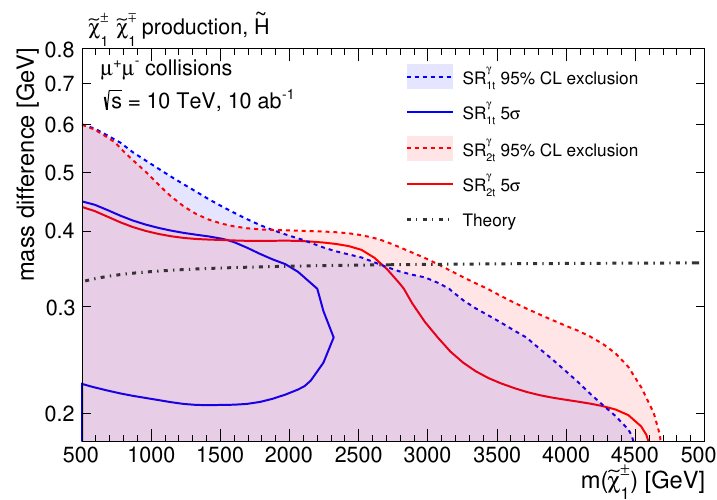
Figure 15. Expected sensitivity using 10 ab − 1 of 10 TeV µ + µ − collision data as a function of the ˜ χ ± mass and mass difference with the lightest neutral state, assuming a pure-higgsino scenario. The mass splitting as a function of the ˜ χ ± mass is shown by the dashed grey line and was calculated at the one-loop level [30,